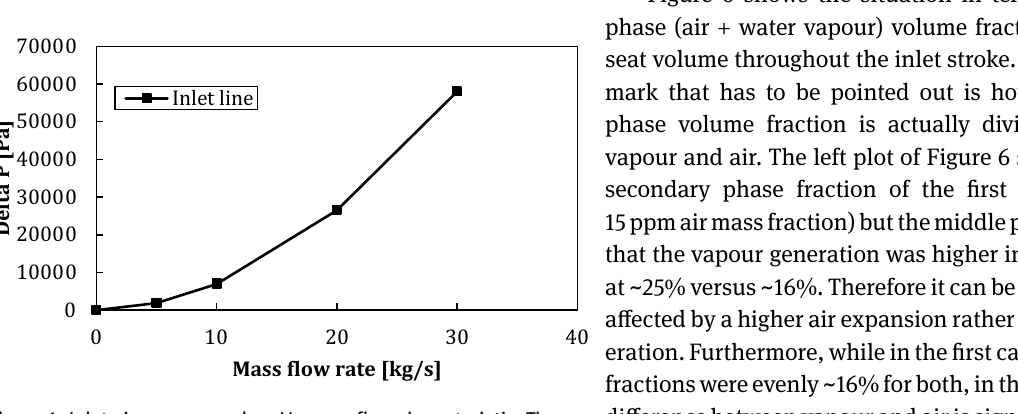
Figure 4. Inlet pipe pressure drop Vs mass flow characteristic. The points of the curve were simulated Figure 4: Inlet pipe pressure drop Vs mass flow characteristic. The by means of a separated steady-state CFD analysis of the inlet pipe only. points of the curve were simulated by means of a separated steady- state CFD analysis of the inlet pipe only.